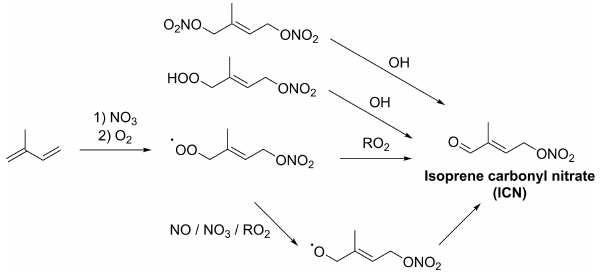
Figure 2. NO 3 -initiated formation of ICN. The formation of 1,4- ICN is shown here; other ICN isomers, as well as additional reaction products, will also be formed.